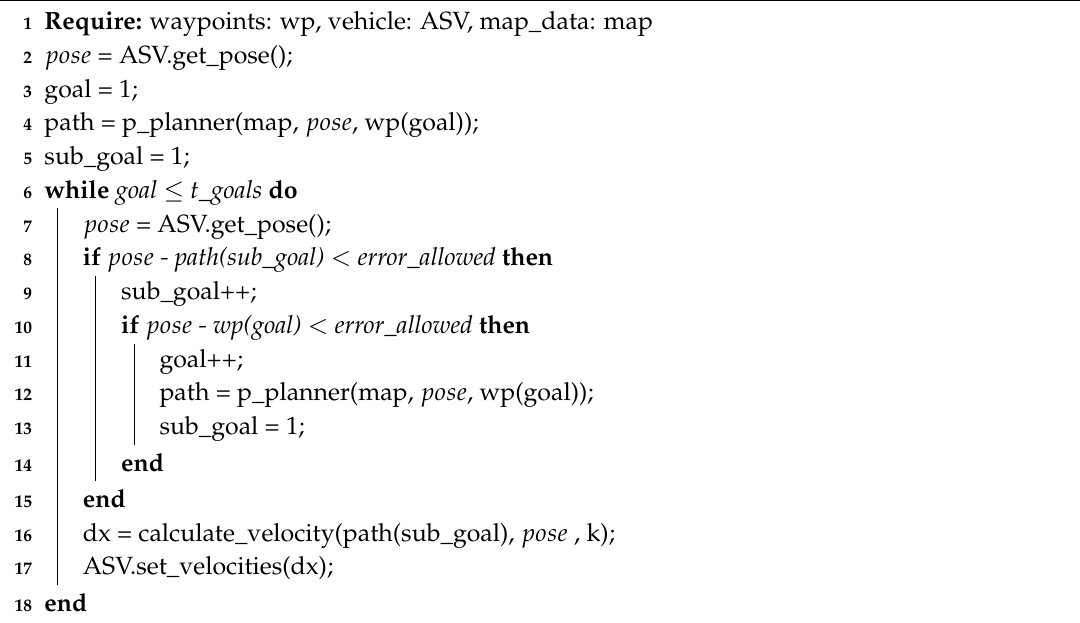
Algorithm 3: Runtime Algorithm, including path